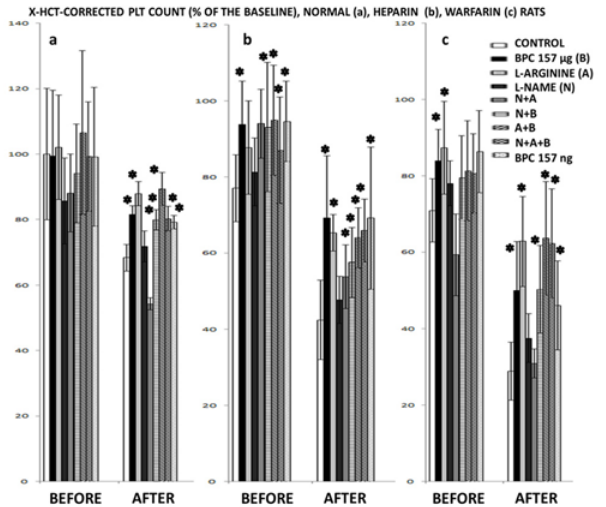
Fig 1. Hematocrit-corrected platelet counts (X) before, and after bleeding period. Hematocrit-corrected platelet counts (X) before, and after bleeding period: (a) in normal rats, BPC 157 (10 μ g/kg, 10 ng/kg), L-NAME (5 mg/kg), L-arginine (100 mg/kg) given alone and/or together,applied intraperitoneally, at 30 minutes before amputation while controls received simultaneously an equivolume of saline (5ml/kg intraperitoneally); (b) in heparin (10 mg/kg intravenously) challenged rats when treated with BPC 157 (10 μ g/ kg, 10 ng/kg), L-NAME (5 mg/kg), L-arginine (100 mg/kg) alone or combined, intravenously, immediately after intravenous heparin while controls received simultaneously an equivolume of saline (0.5 ml/kg intravenously); (c) in warfarin rats (warfarin given intragastrically (1.5 mg/kg) once daily for 3 consecutive days, with the last challenge was at 3 hours before the bleeding procedure). BPC 157 (10 μ g/kg, 10 ng/kg) was given immediately after any warfarin challenge, intragastrically while controls received simultaneously an equivolume of saline (5.0 ml/kg intragastrically). We applied L-NAME (5 mg/kg), L-arginine (100 mg/kg) alone or combined, intraperitoneally, at 30 minutes before amputation. Mean ± SD, * P < 0.05 at least vs. control, 10 rats at least per